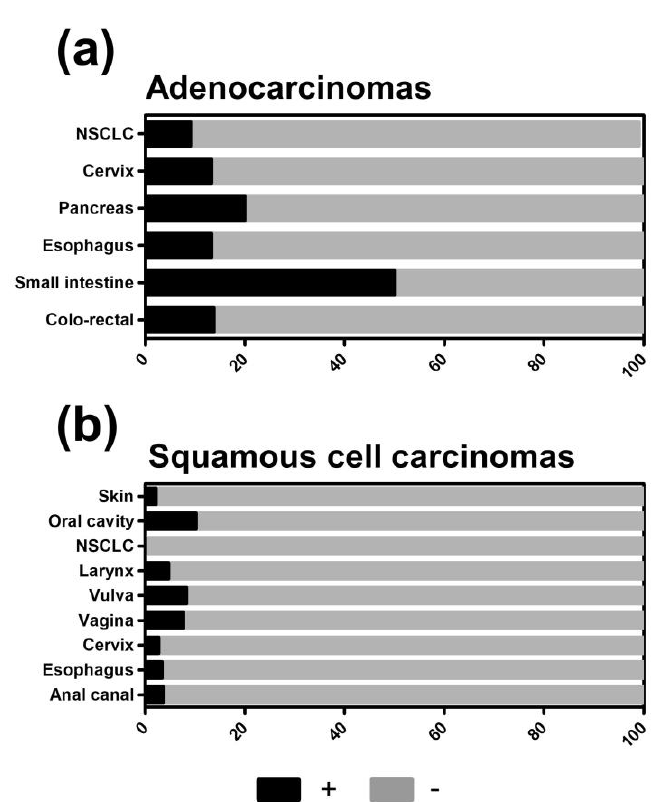
Figure 3. Percentage of thioredoxin interacting protein (TXNIP)-positive tumor samples of all tumor samples in adenocarcinomas ( a ) and squamous cell carcinomas ( b ) on multi-tumor TMA. ‘+’ = high, ‘−‘ = low TXNIP protein expression. NSCLC = Non-small cell lung cancer.